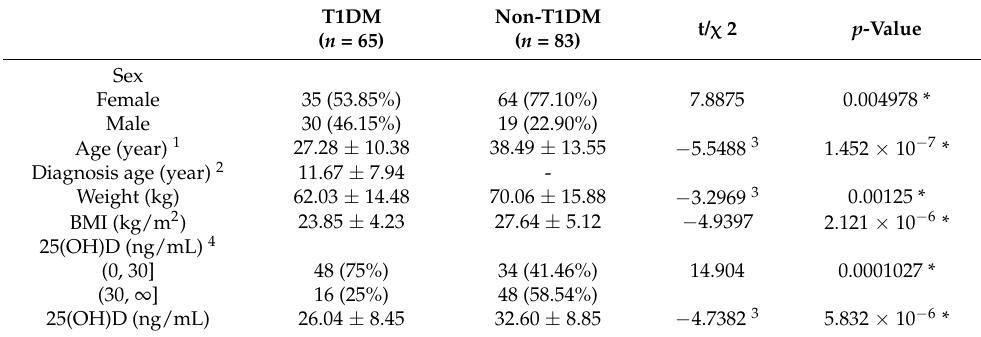
Table 1. Clinical characteristics of T1DM and non-T1DM groups.